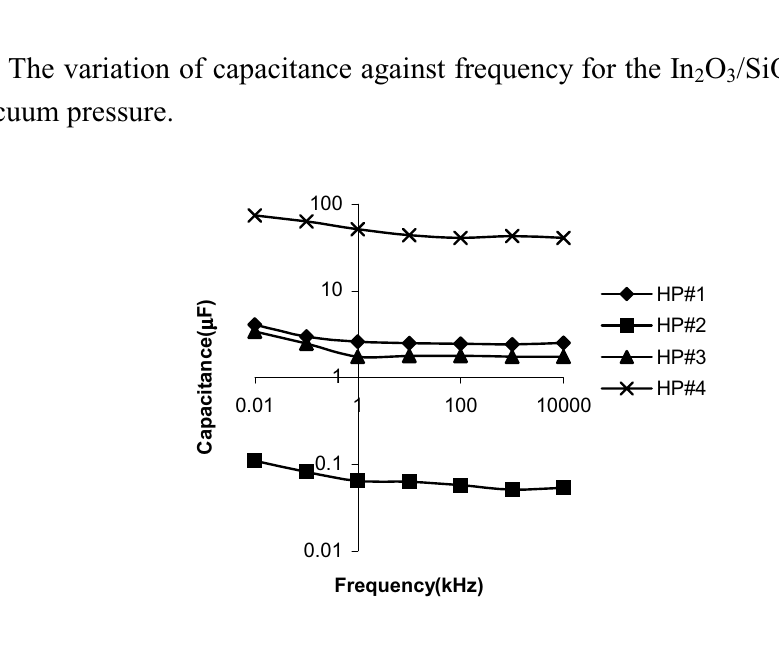
O /SiO samples produced 2 3